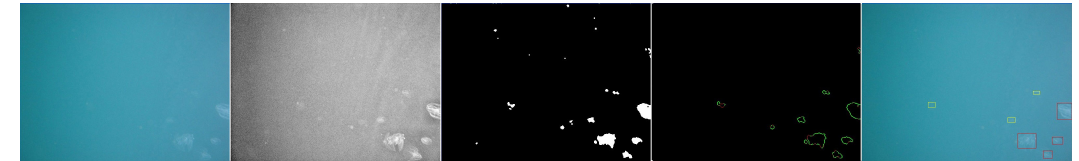
Figure 2. An example of the image processing steps. From left to right: original image, CLAHE enhancement of the original image, background/foreground segmentation, contours extracted from the original image by the Sobel operator, Region of Interest (RoI)